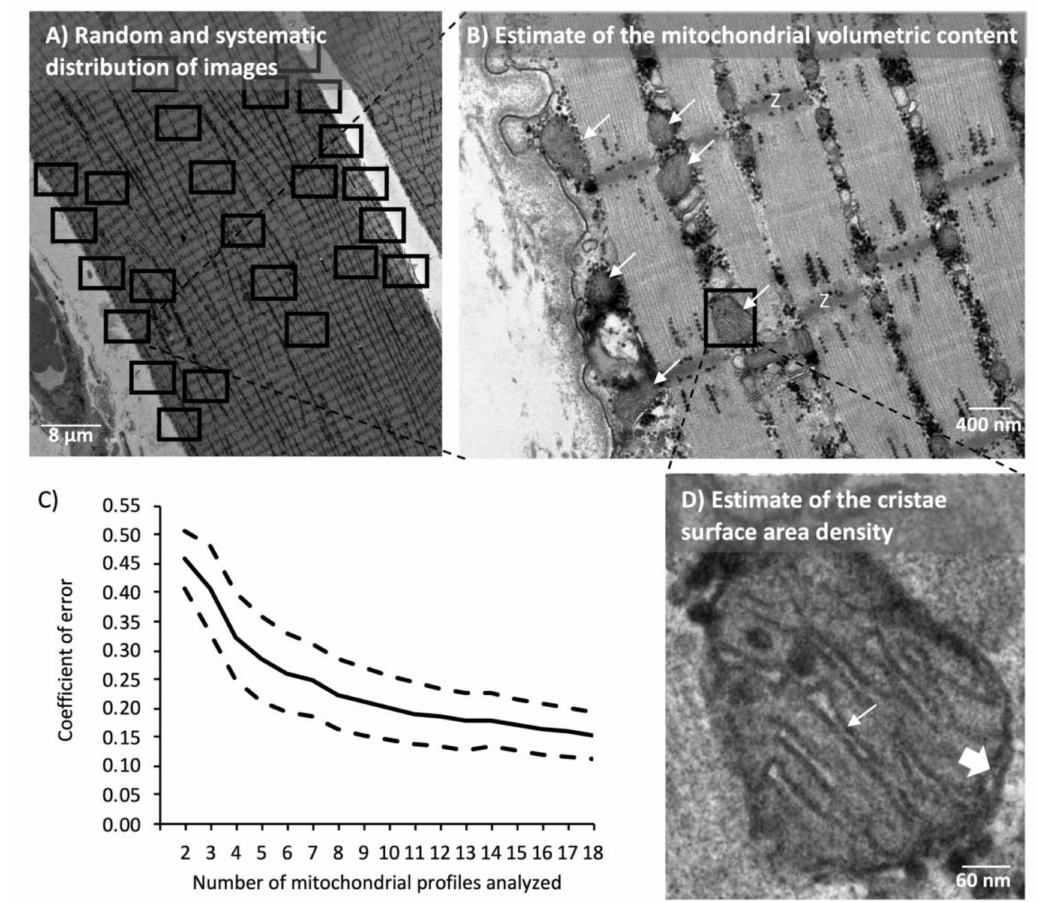
Figure 2. Analysis of mitochondrial volumetric content and cristae surface area density by transmission electron microscopy. ( A ) 24 images were photographed in a randomized systematic order. ( B ) Representative image used for the quantification of the mitochondrial volumetric content. White arrows point at examples of mitochondrial profiles. Z indicates Z-disc. ( C ) Mean (continuous line) and 95% CI (dashed lines) of coe ffi cient of error after analysis of up to 18 profiles (n = 27 subjects). ( D ) Representative mitochondrial profile used for quantification of cristae surface area density. The thin arrow points at one cristae with a double-leaflet. The thick arrow points at an example of the double-leaflet of the outer